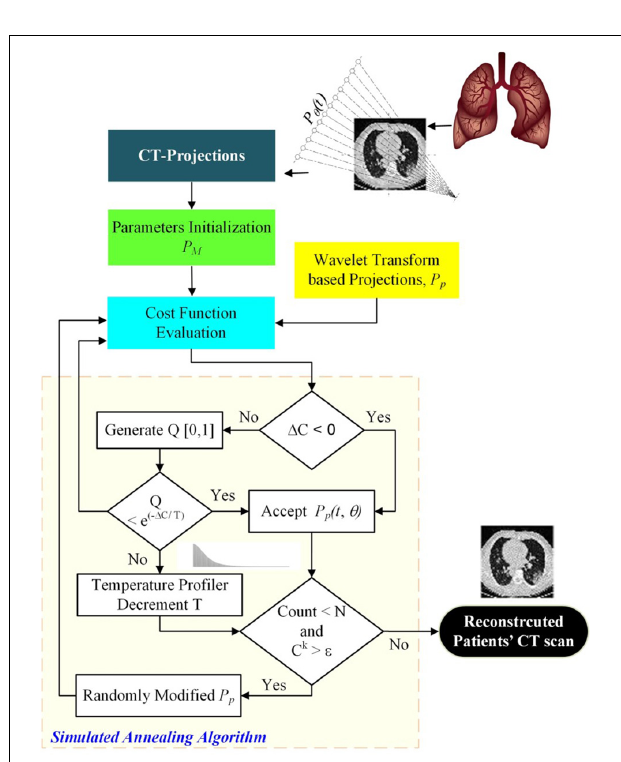
filter matrix R W = WR fbp W T using Daubechies or Haar